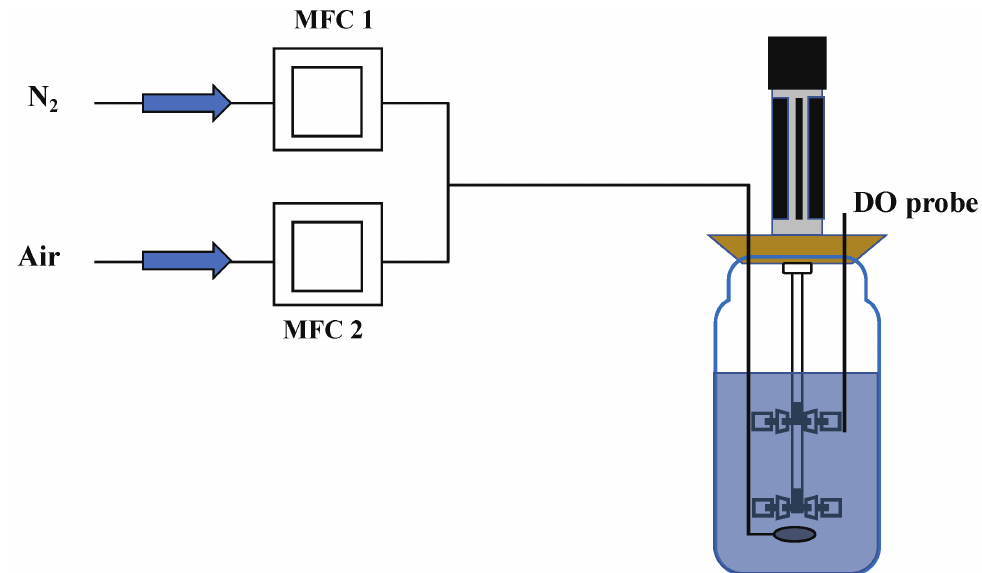
Figure 18. A schematic overview of nitrogen and compressed air control logic used in the DO shift and ramp